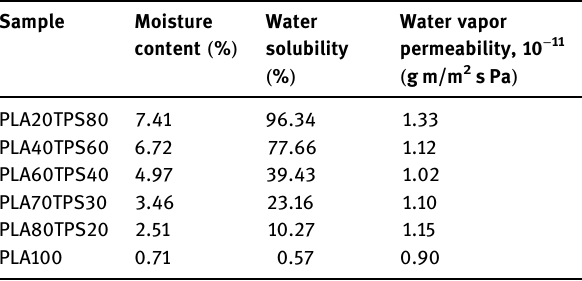
Table 4: Moisture content, solubility, and water vapor permeability of neat PLA and PLA/TPS blend bionanocomposites